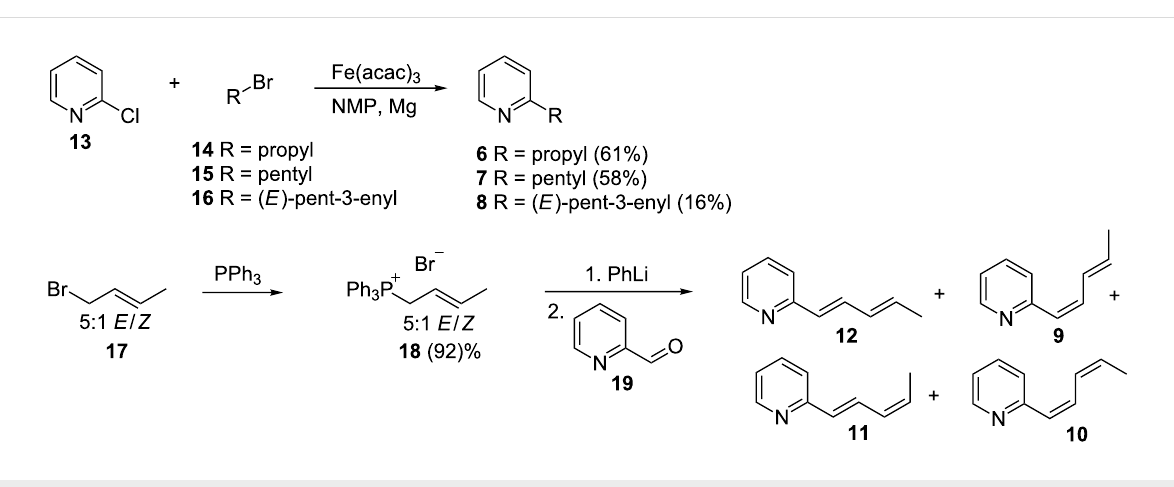
Scheme 1: Synthesis of streptopyridines A to E ( 8 – 12 ) and the 2-alkylpyridines 6 and 7